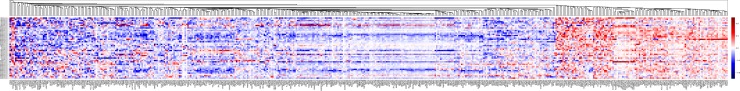
Heat map and hierarchical clustering of 517 DEGs in the contrasts M10h vs M0 and M7d vs M0.Each row corresponds to one subject in the respective contrast and each column represents a DEG. Normalized sequence read counts were rescaled to lie in range [0,1] and further used to estimate the difference between the gene expression levels in two time-points depending on the particular contrast. DEGs with analogous expression values were clustered at the column level, the list of DEGs were obtained by edgeR-robust method.